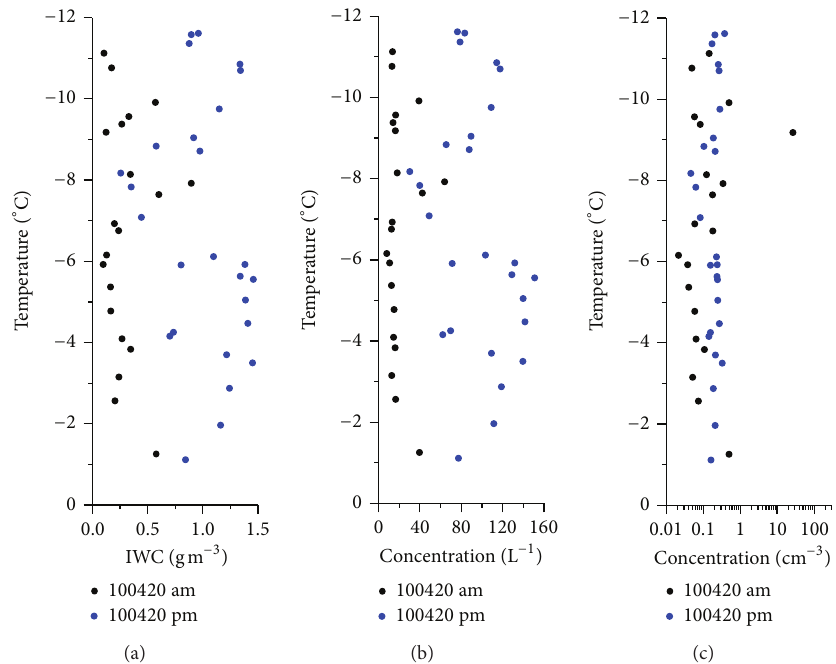
Figure 7: Vertical profiles of (a) IWC (g m −3 ), (b) ice particle concentrations (L −1 ) from the CIP and (c) cloud droplet concentrations (cm −3 ) from the CDP for the 100420 cloud case during the two ascents.